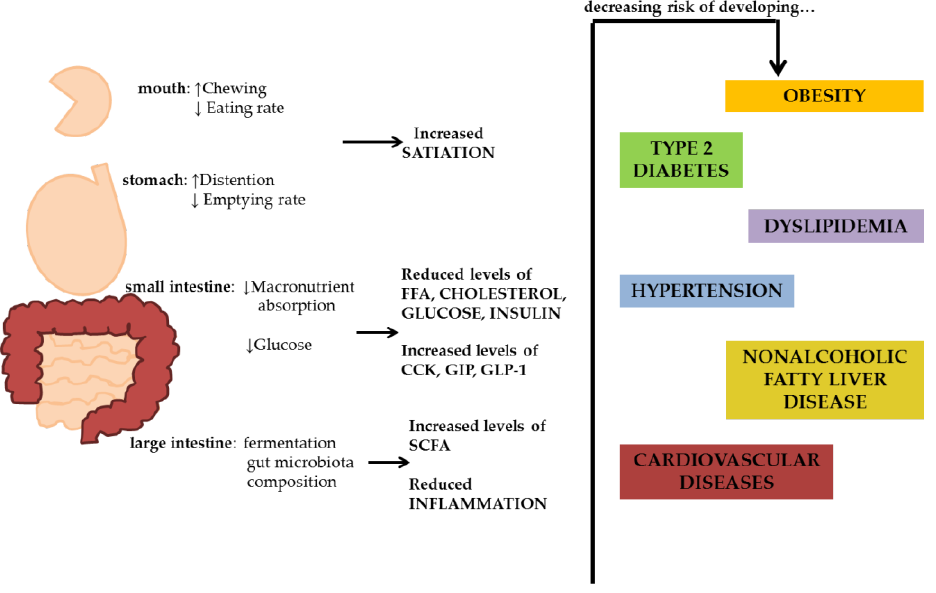
Figure 2. Plausible mechanisms of action whereby fibre may influence body weight and its related common chronic diseases.CCK: cholecystokinin; GIP: gastric inhibitory peptide; GLP-1: glucagon like peptide 1; SCFA: short chain fatty acids.